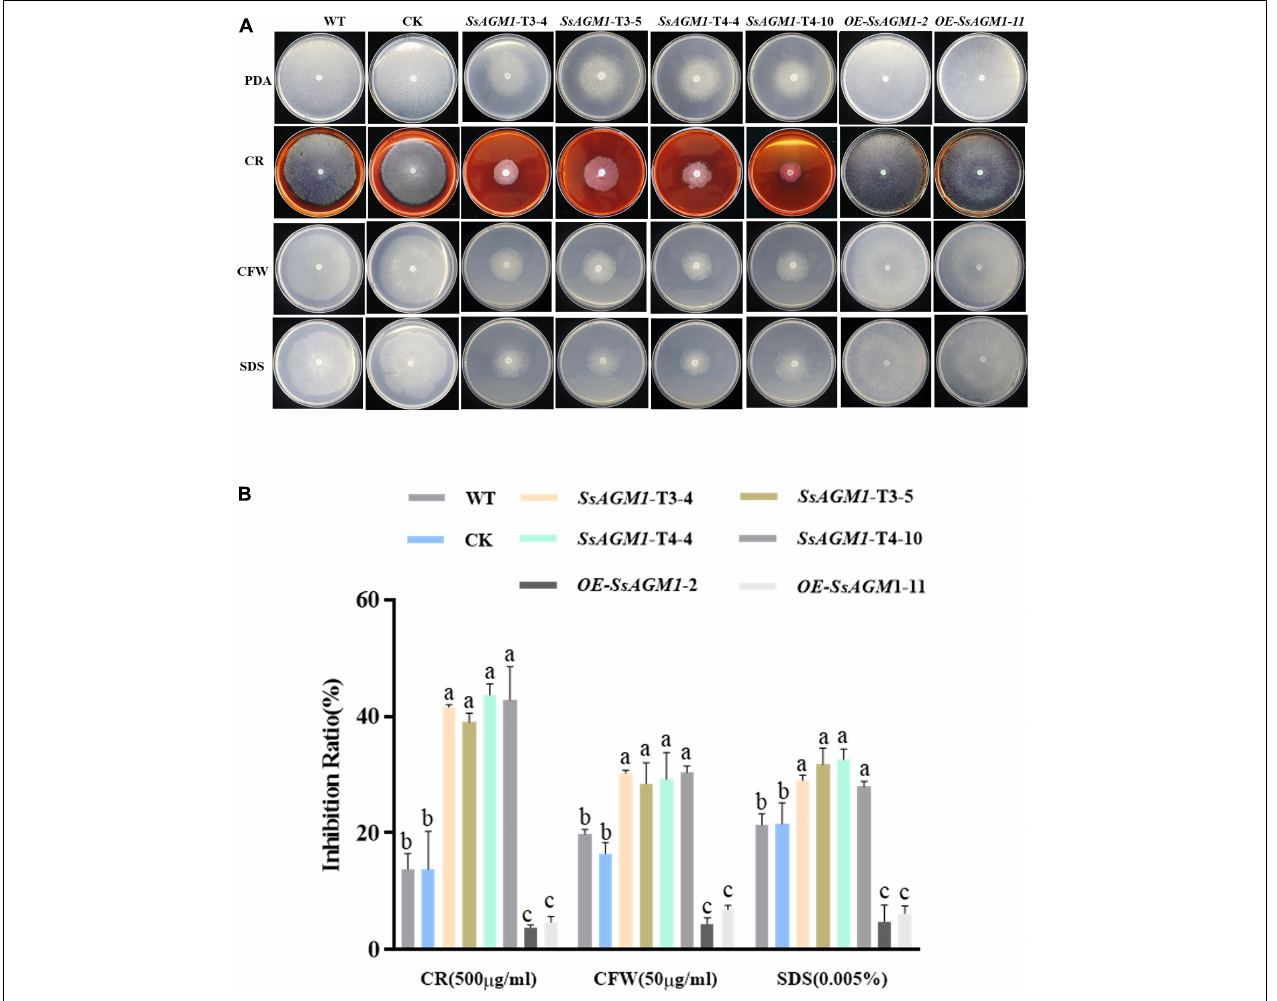
FIGURE 4 | SsAGM1 contributes to the tolerance to inhibitors of cell wall synthesis in Sclerotinia sclerotiorum . (A) The growth phenotypes of wild-type strain, control strain, gene-silenced transformants, and overexpression transformants on PDA supplemented with CR, SDS, and CFW for 48 h after inoculation. WT, Wild-type strain; CK, the control strain; CFW, Calcofluor white; CR, Congo red; SDS, sodium dodecyl sulfate. (B) The inhibition rate of hyphae growth on PDA supplemented with different inhibitors of cell wall synthesis. Inhibition rate = (diameter of untreated strain - diameter of treated strain)/(diameter of untreated strain × 100%). Data represent means ± SD. One-way ANOVA; n = 3; different letters indicate statistically significant differences ( p <